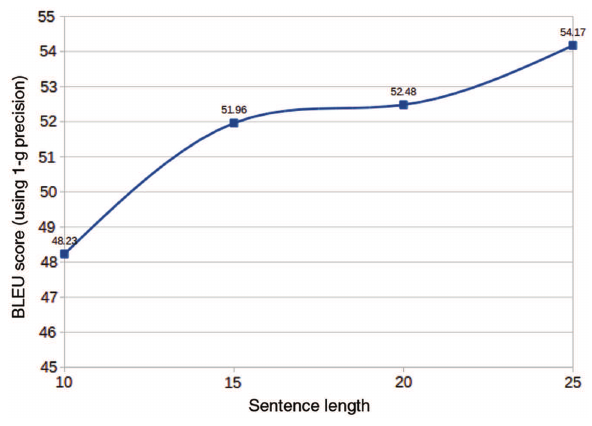
Figure 8: BLEU Score Achieved by NMT System for Different Sentence